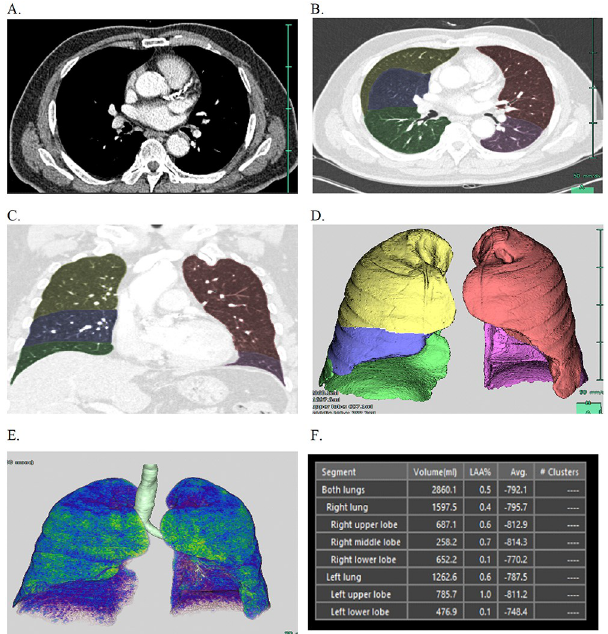
Fig 2. Process of obtaining emphysema index and lobe-specific emphysema index. Computed tomography image (A) is converted to a three-dimensional volume rendering image using a commercially available software, Synapse 3D Vincent ™ . Lobes are divided via the automatic segmentation technique and manual correction (B, C), and the volume of each lobe is produced (D). Lobe-specific emphysema index for each lobe is obtained by defining the emphysema index with an attenuation value lower than -950 Hounsfield unit (E,